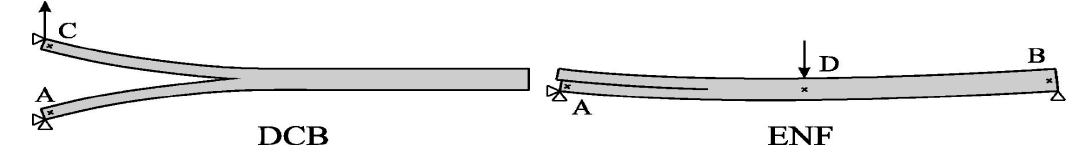
Figure 1. Representation of the load introduction in the two test types performed in this work